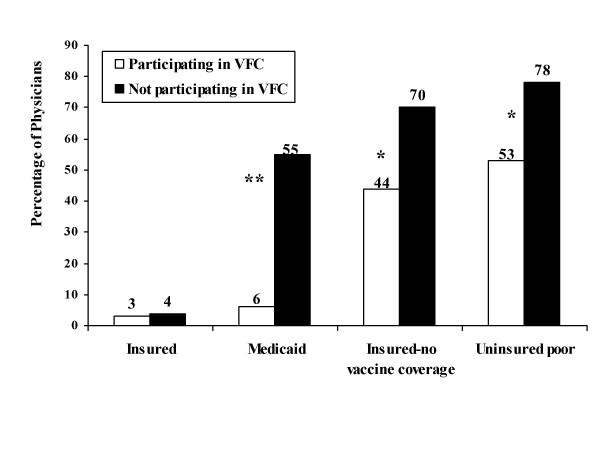
Percentage of physicians in 2003 likely to refer children to public health department vaccine clinics by participation in VFC and by patient insurance status. Vaccine, Zimmerman, RK, et al. Legend: Likely is defined as 6 to 10 on a scale of 0 to 10. ** P ≤ 0.001 * P ≤ 0.05